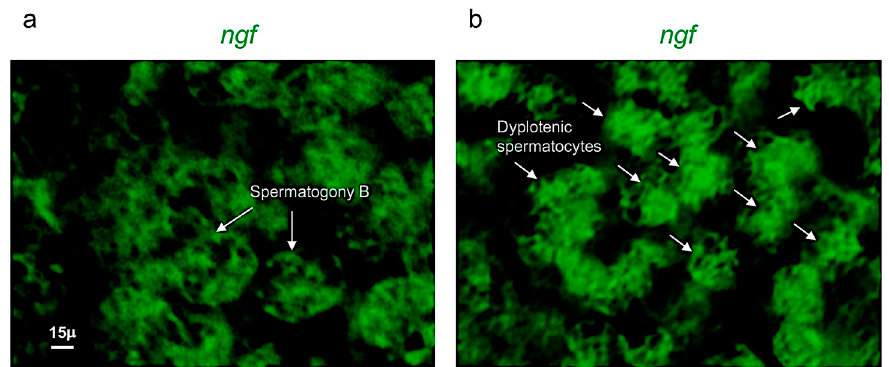
Figure 3. Ngf is specifically expressed in spermatogony B and dyplotenic spermatocytes. High magnification, fluorescence in situ hybridization of ngf , specifically expressed in ( a ) spermatogony B and in ( b ) dyplotenic spermatocytes in adult zebrafish testis. Scale bar: 15 µ ( a , b ).